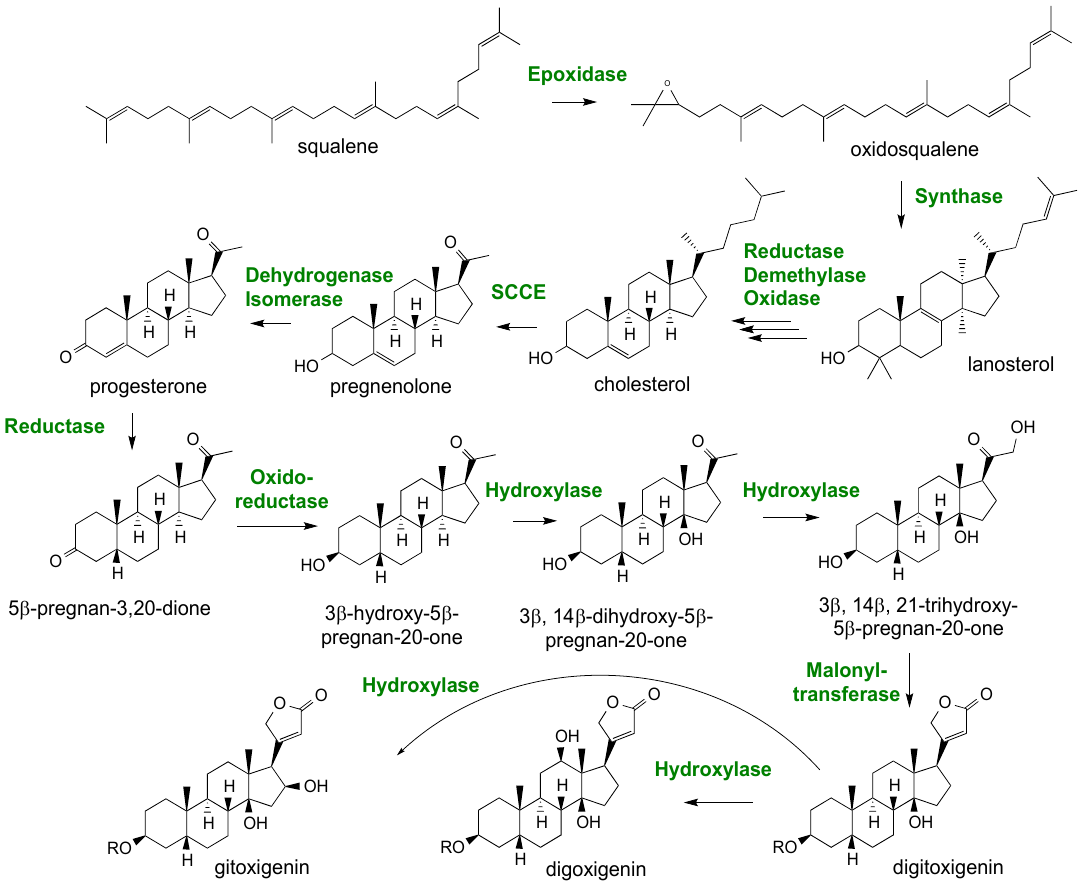
Figure 12. A proposed pathway for digitoxin biosynthesis in Digitalis